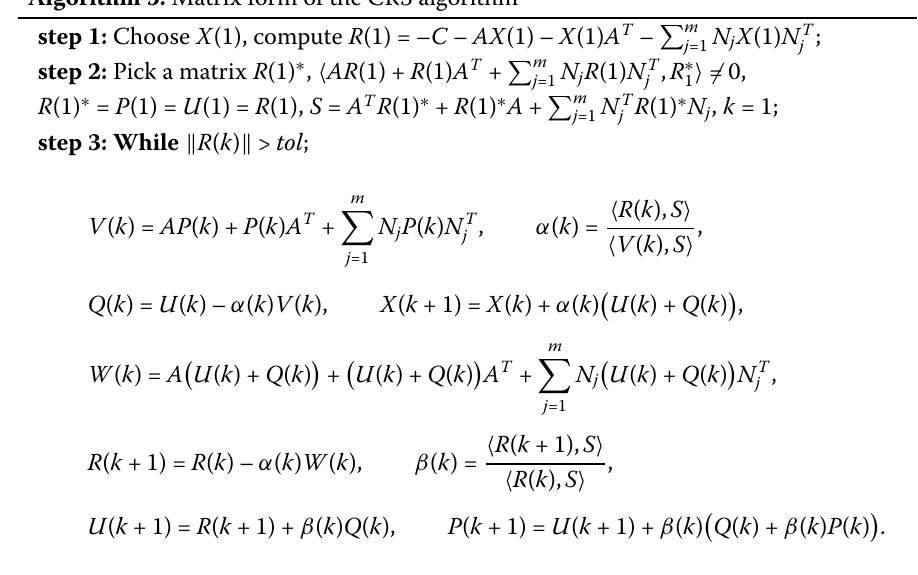
Algorithm 5: Matrix form of the CRS